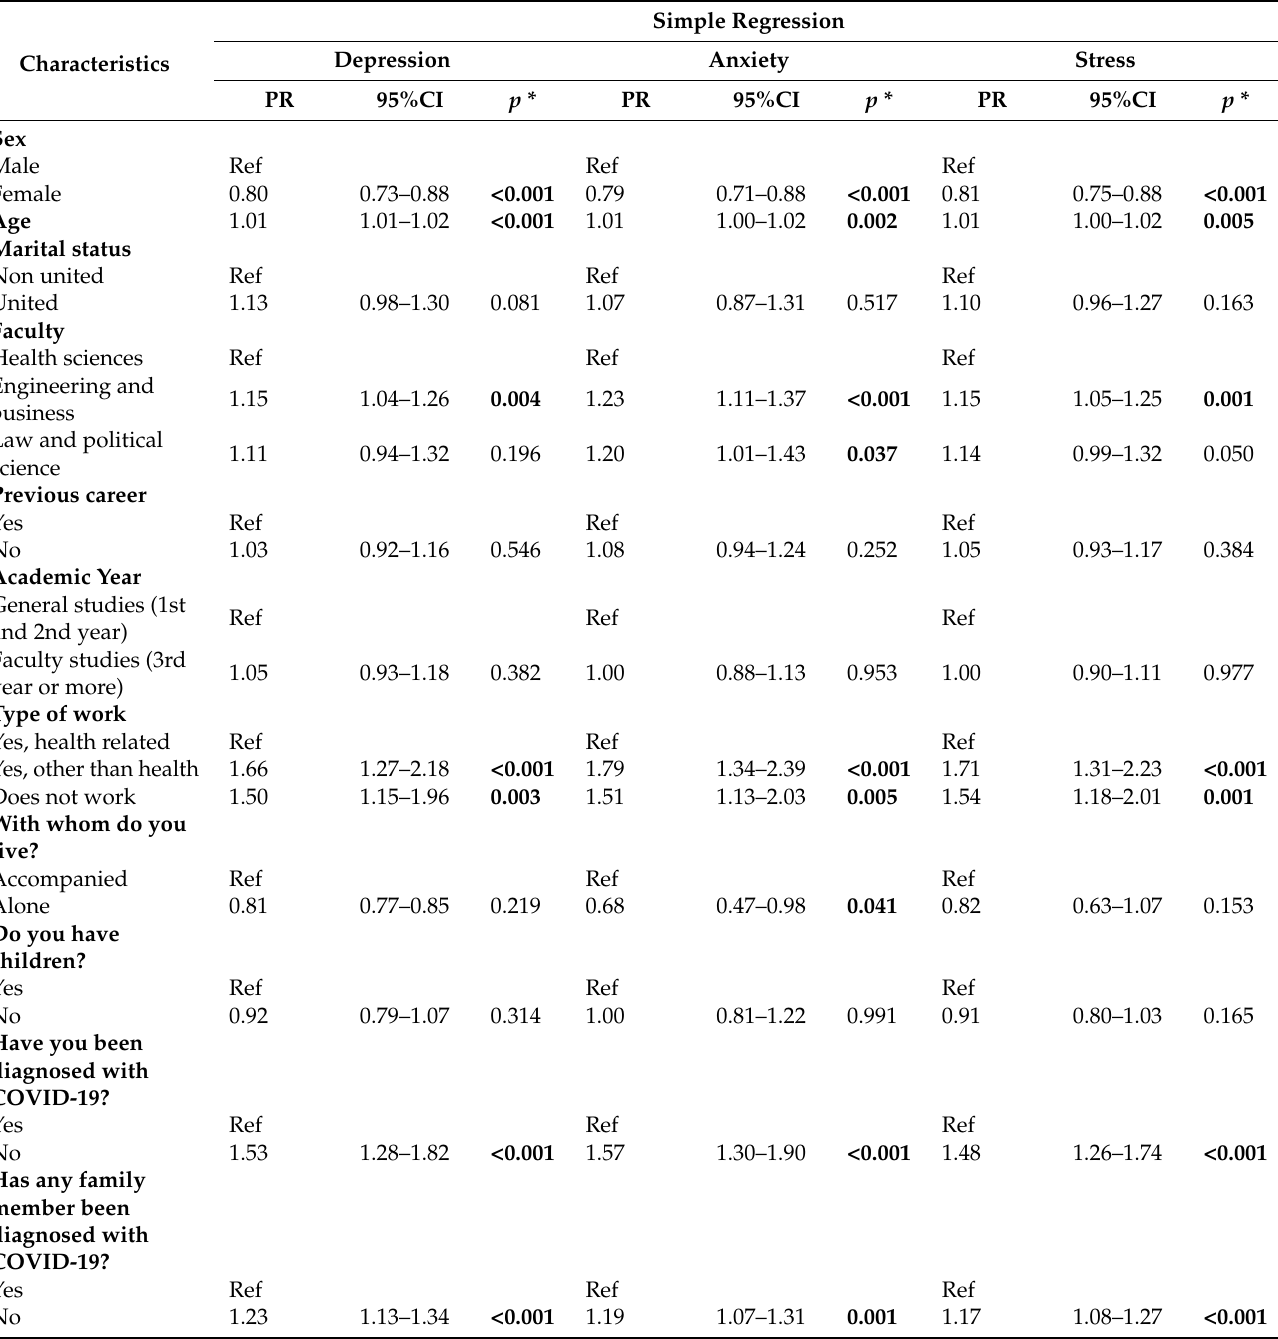
Table 3. Factors associated with presenting depression, anxiety, and stress in students of the Univer- sidad Norbert Wiener. Simple